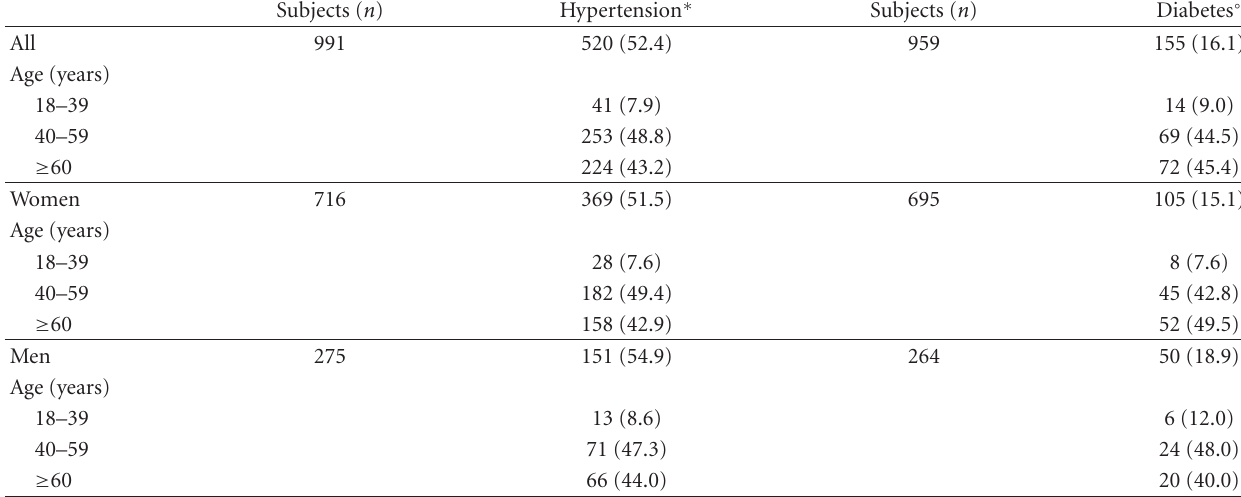
Table 2: Prevalence of hypertension and diabetes in the Moldova population aged ≥ 18 years.